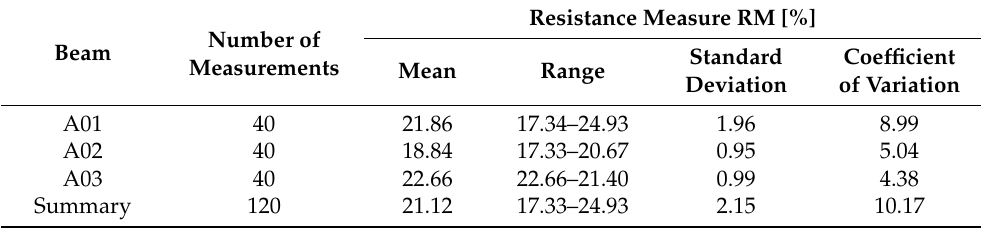
Table 8. Mean drilling resistance test results.